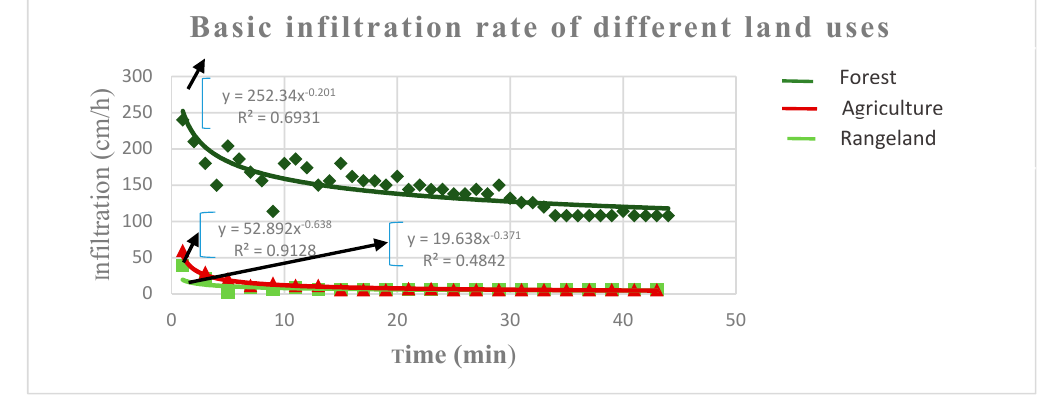
Figure 9. Comparison of basic infiltration rates of different land uses.